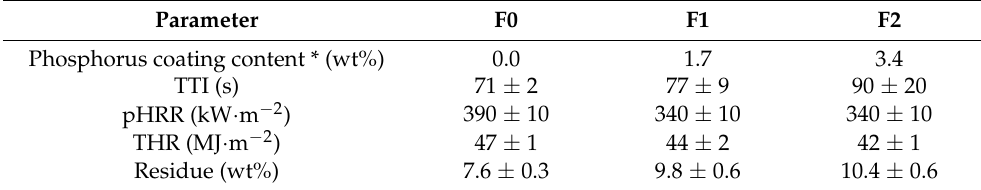
Figure 10. Cone calorimeter heat release rate curves of the coated wood samples. Table 4. Main cone calorimeter results of the coated wood samples.